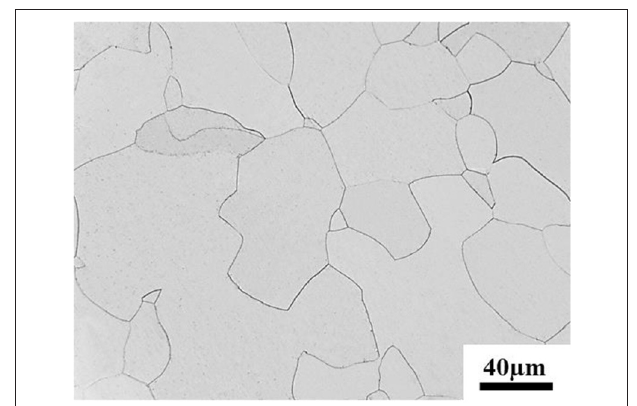
FIGURE 1 | Microstructure of experimental alloy after solution treatment consisting of β single